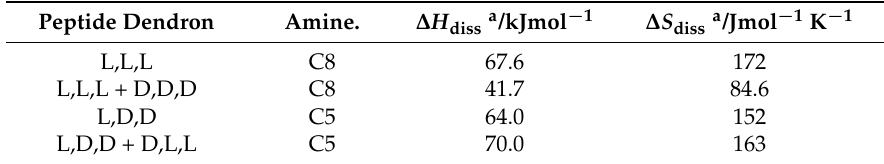
Table 3. Thermodynamic data derived from van ’t Hoff plots as determined using NMR methods.